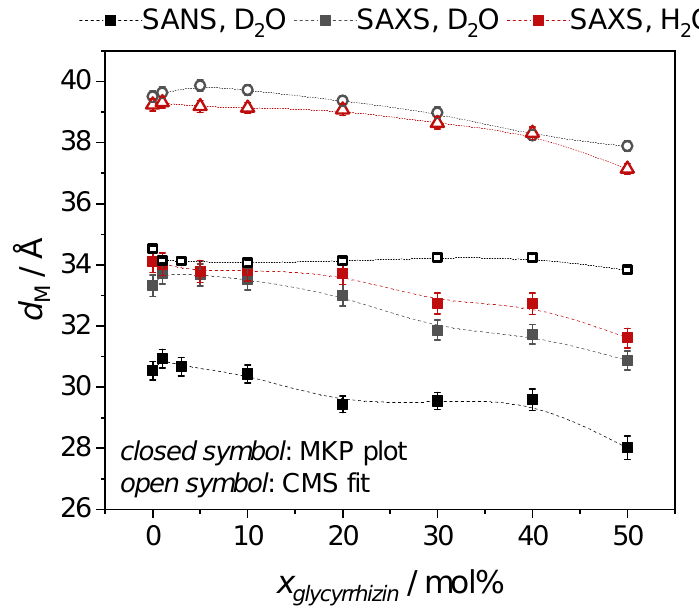
Figure 6. Membrane thicknesses obtained from model-dependent CMS fitting as well as from model- independent MKP approximation for samples in D 2 O buffer measured by SANS ( d D ) and 2 O, SANS SAXS ( d D ) and samples in H 2 O buffer measured by SAXS ( d H ). 2 O, SAXS 2 O, SAXS As expected, the membrane thicknesses obtained by SAXS for samples in D 2 O and H 2 O buffer do not differ significantly (especially for low x glycyrrhizin ) and d m,MKP decreases slightly with increasing x glycyrrhizin . Values determined by SAXS are ≈ 3–4 Å higher com- pared to the ones obtained from SANS. This seems reasonable because different membrane contrasts do not lead to exactly the same membrane thickness values. Pencer et al. [57] also determined the membrane thickness of DOPG by the MKP method from SANS data